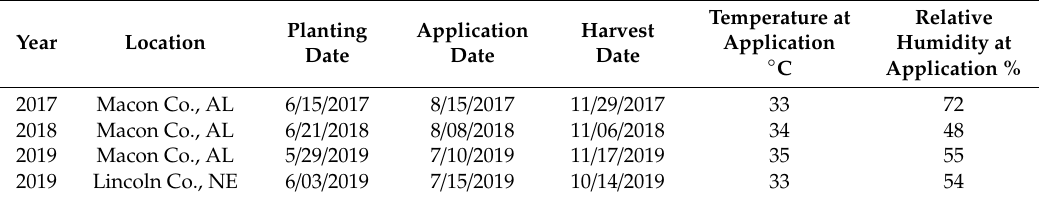
Table 3. Dates of soybean planting, dicamba application, harvest, and temperature and humidity at time of application.